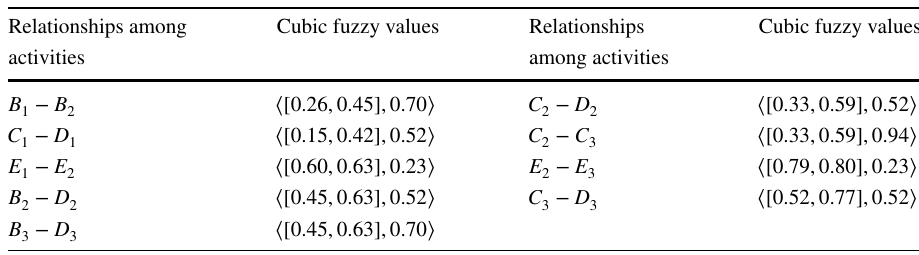
Relationships among